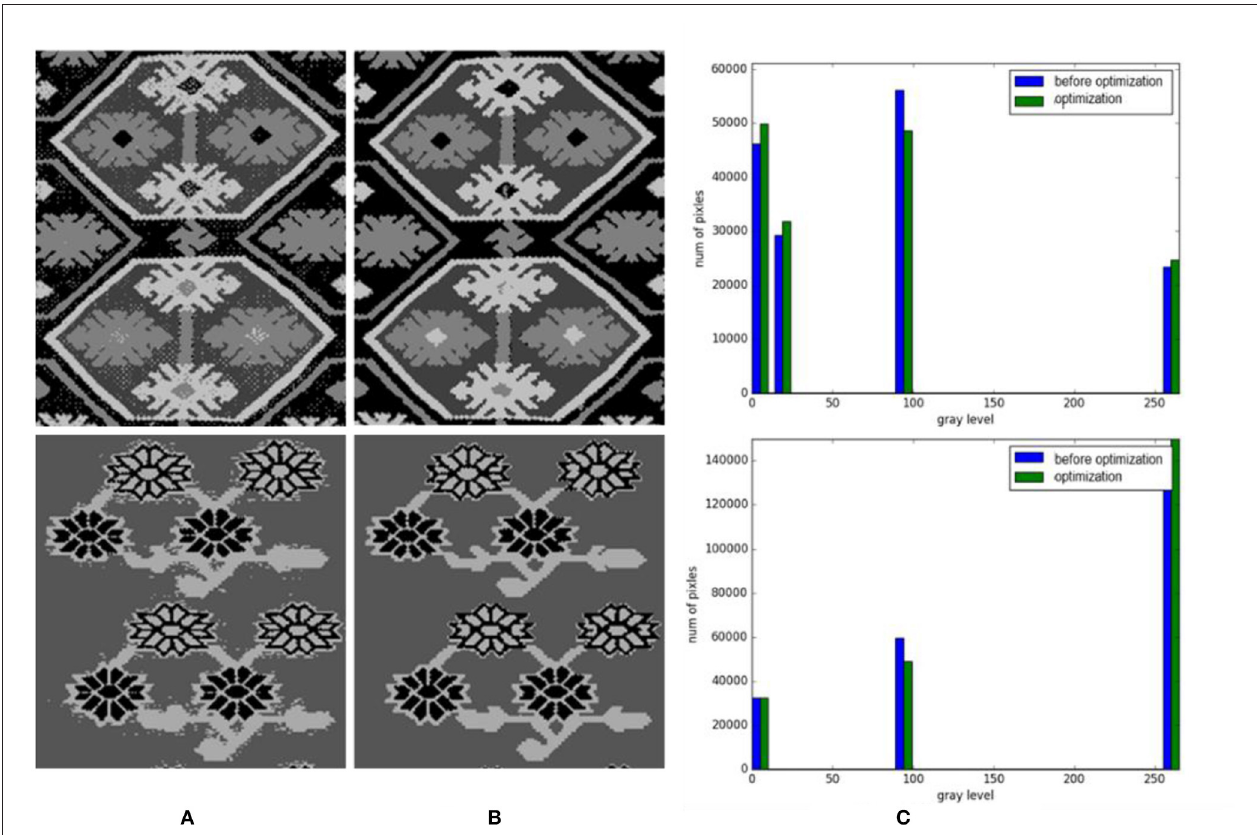
FIGURE 9 | Gray histograms of cluster contrast optimization. (A) Before optimization. (B) Optimization. (C) Gray